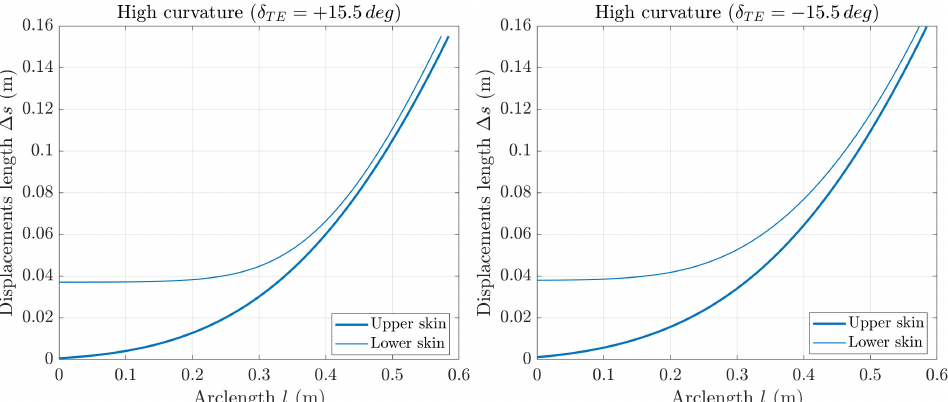
Figure 8. Displacement lengths of the morphing skin for optimal downward and upward deflections.